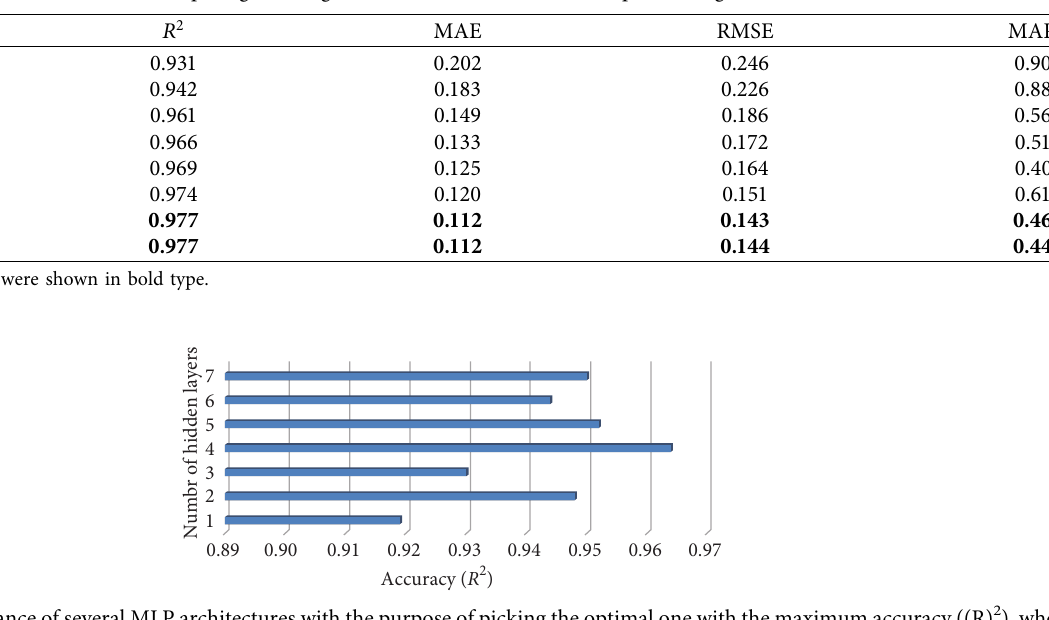
Table 7: Comparing stacking ensemble model with the best performing ML models.